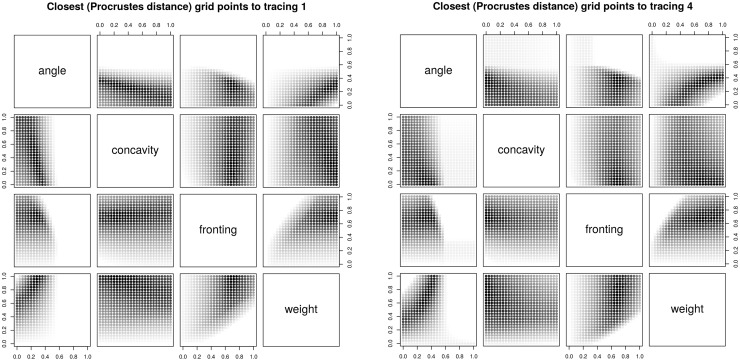
Closest (in terms of Procrustes distance) 100,000 grid points to two representative tracings.Each dot represents one of the top closest 100,000 grid points to tracing 1 (left panel) and tracing 4 (right panel, respectively), the darker the color the closer it being to the tracing. Each panel represents a 2D projection on two parameters of the 4-dimensional parameter space.